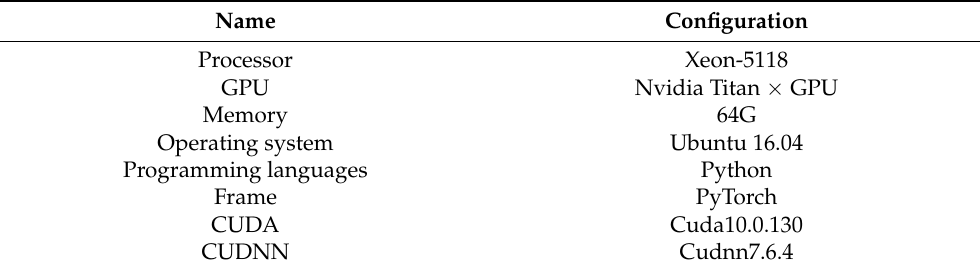
Table 2. Model training